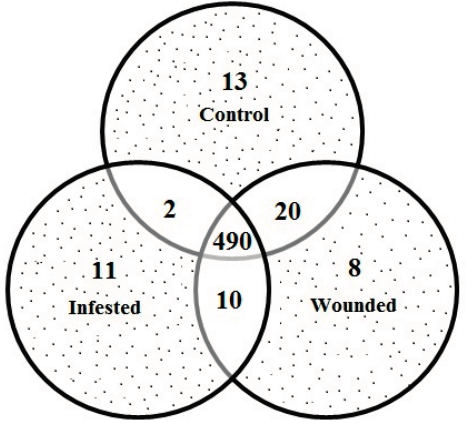
Figure 3. Venn diagram for the relative distribution of differentially expressed proteins spots in control, mechanically wounded and RPW infested date palm samples. The non-overlapping segments of diagram represent the number of proteins that were significantly upregulated (>1.5-fold) in the corresponding group when compared with the other two groups. The overlapping region between any two groups represents the number of proteins spots significantly upregulated (>1.5-fold) compared to the third one. While the central overlapping region represents the protein spots where no any statistically significant change was